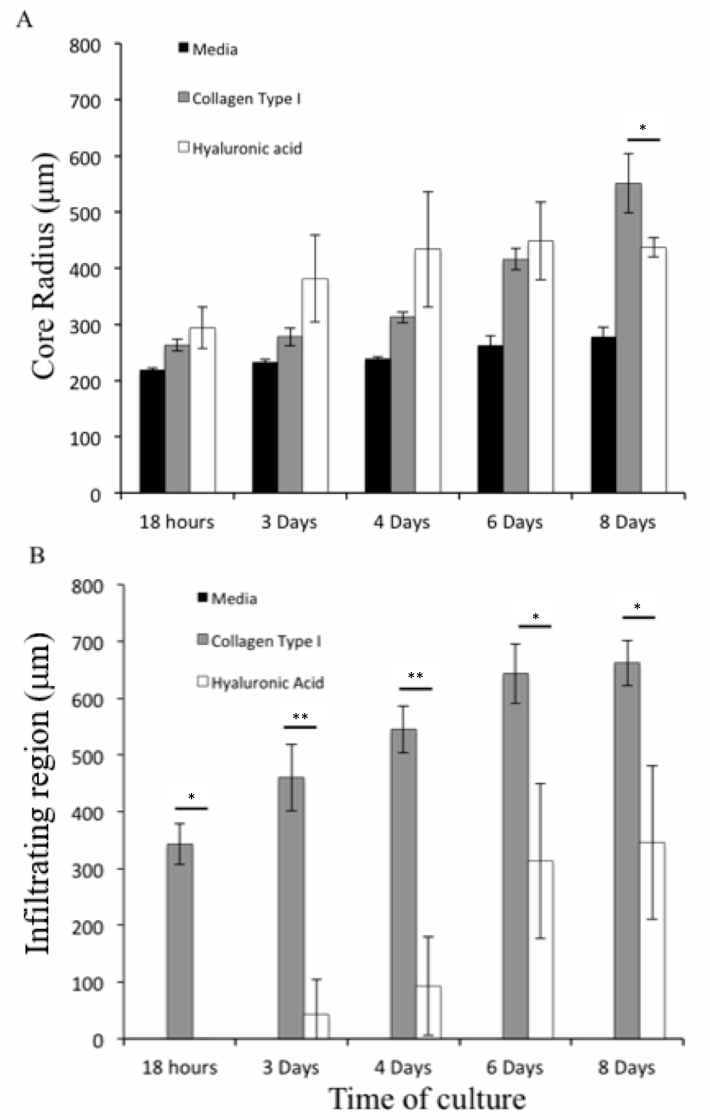
Figure 13. Tumor spheroid growth over time under different conditions. Variation of the tumor core radius ( A ) and infiltrating region size ( B ) over time for spheroids suspended in free medium (black bars), in COL hydrogels (gray bars) and in HA hydrogels (white bar). Note that no infiltrating region can be detected in the case of spheroids growing suspended in free medium. Statistical analysis was undertaken using t -test multiple comparison with a confidence level of 95% ( p < 0.05). GraphPad was